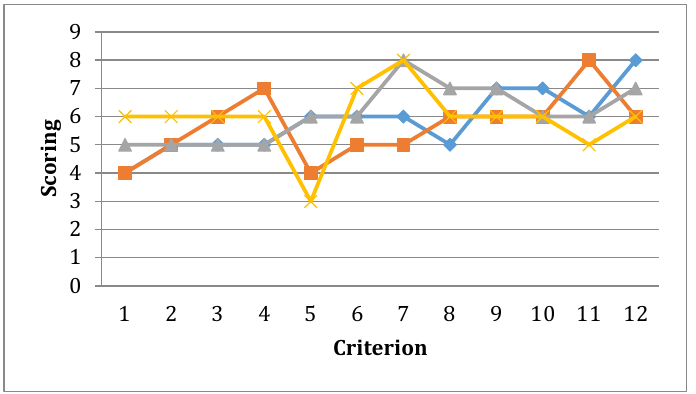
Blue, thermal spray: Red, arc welding: purple Source : Jiang, Zhang & Sutherland